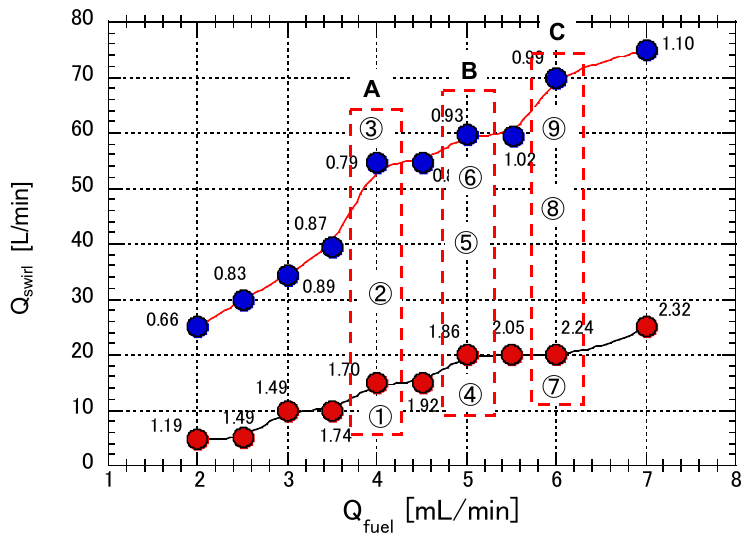
Figure 10. Direct photo of these typical flames.